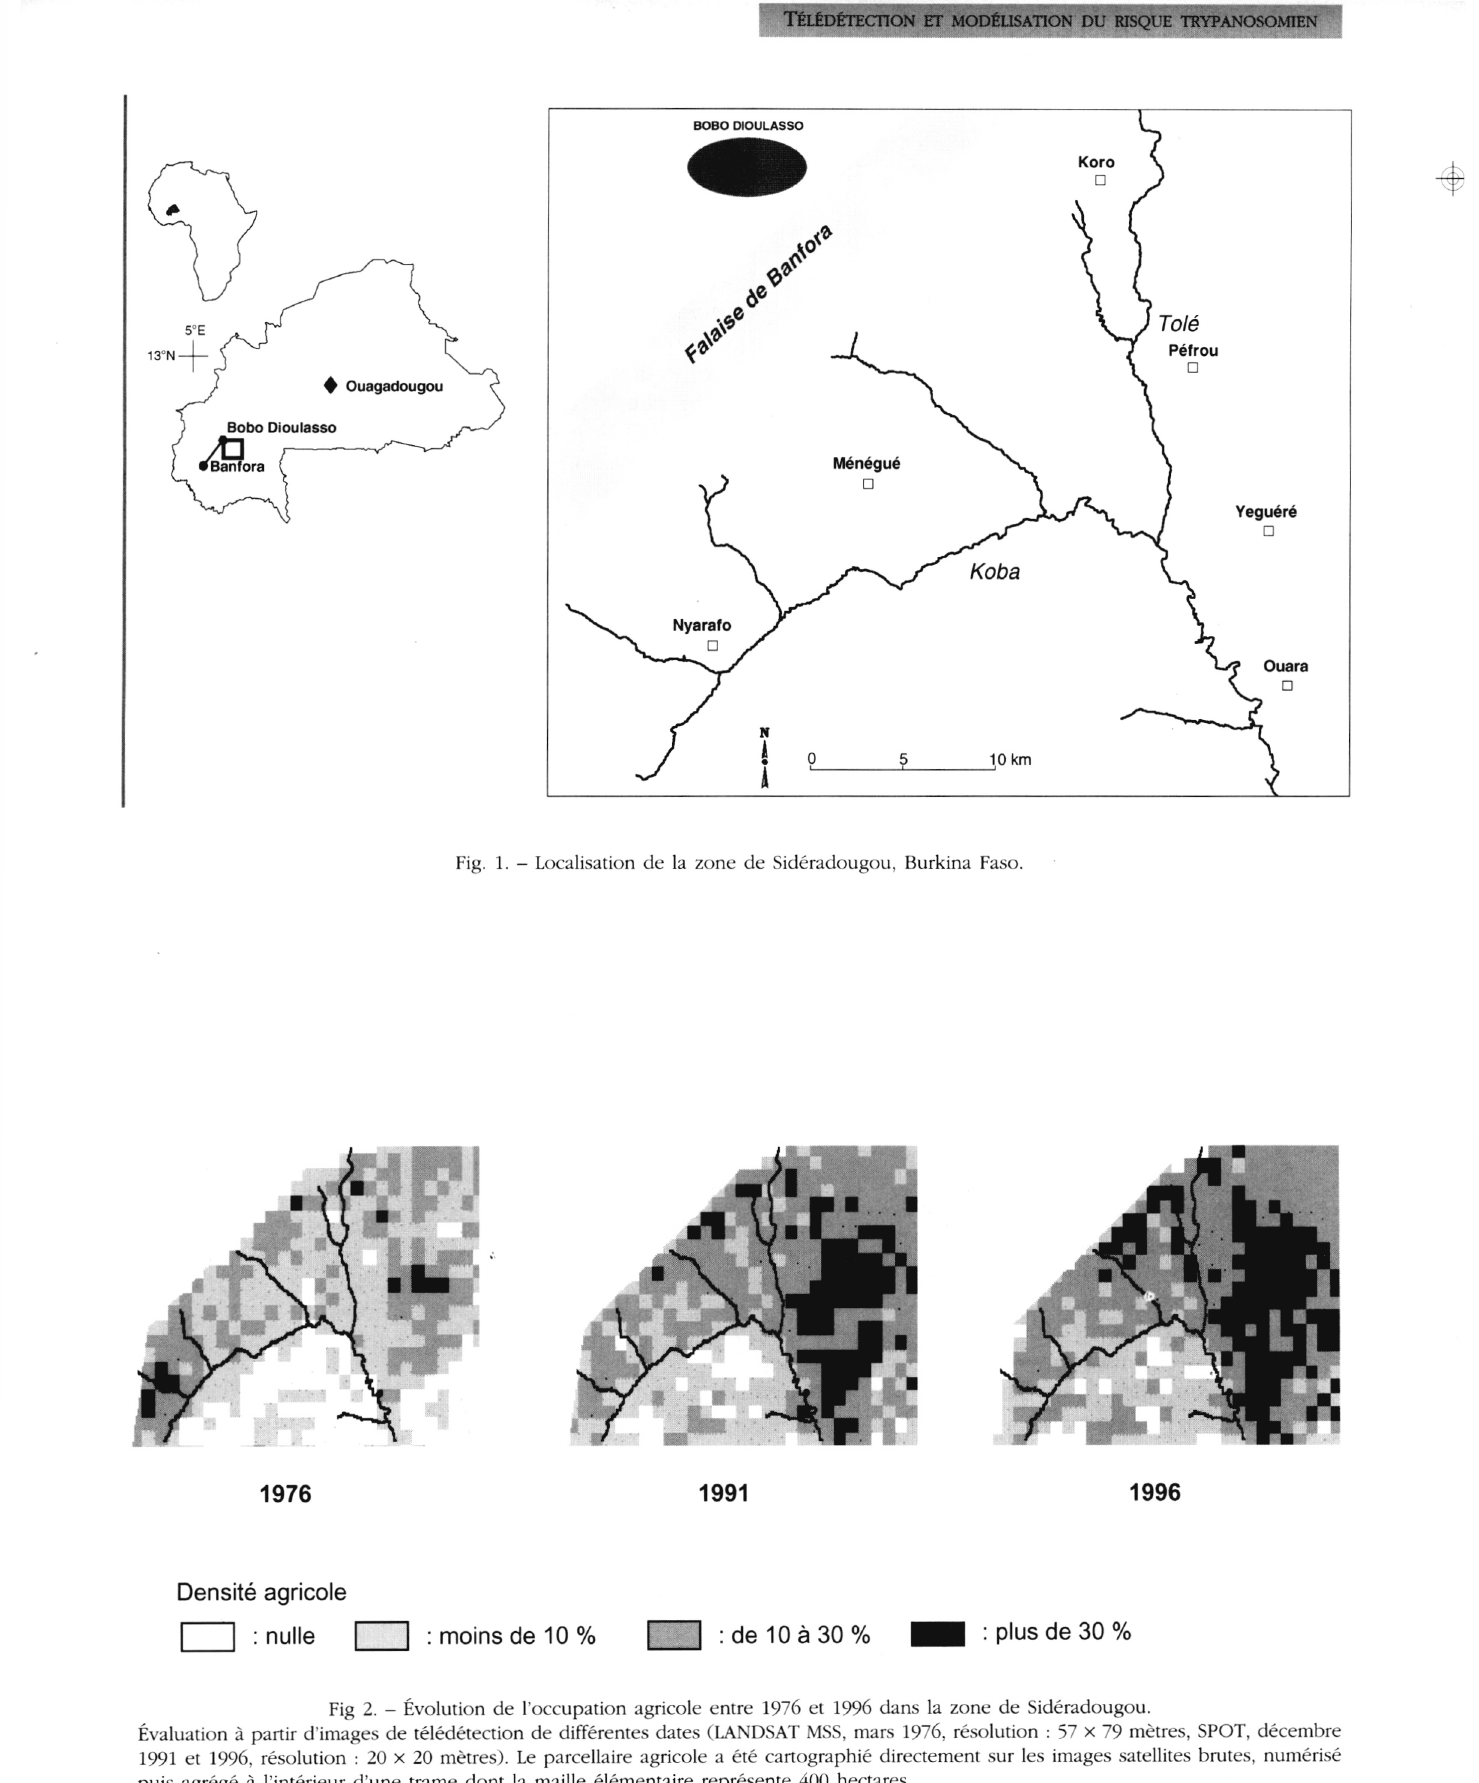
Fig. 1. - Localisation de la zone de Sidéradougou, Burkina Faso.